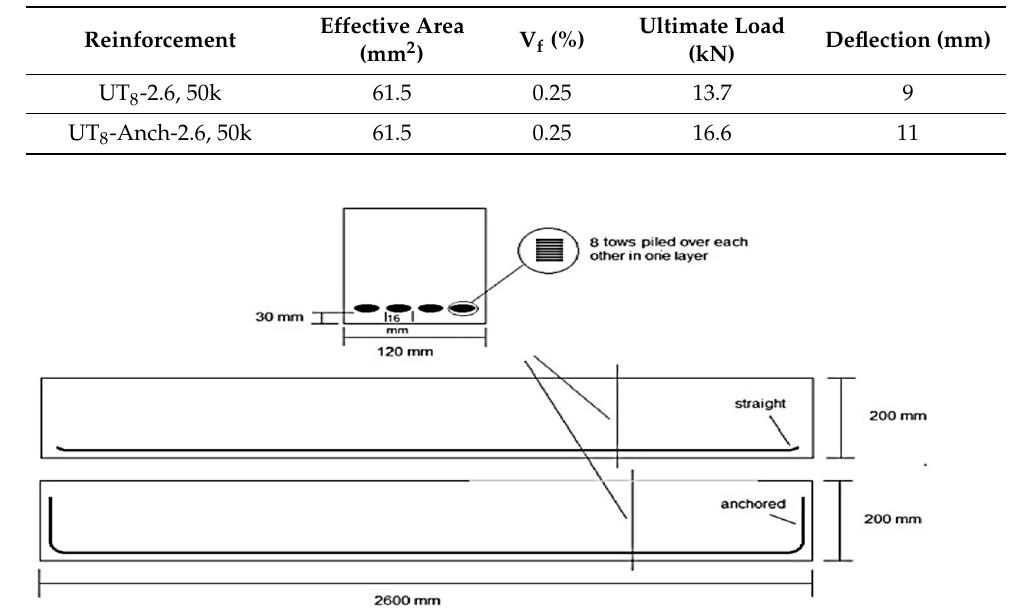
Figure 16. Details of reinforcements in straight and anchored end TRC beams.